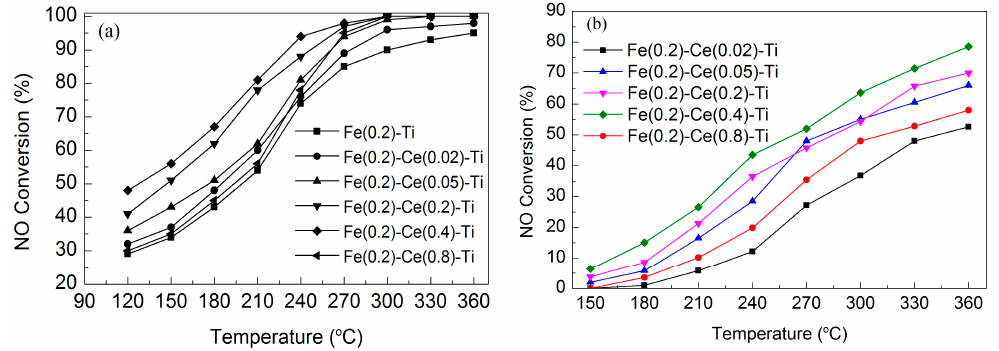
Figure 2. NO conversion of various Fe–Ce–Ti catalysts at different GHSVs: ( a ) GHSV = 90,000 h − 1 and ( b ) GHSV = 180,000 h − 1 . Reaction conditions: [NO] = [NH 3 ] = 500 ppm, [O 2 ] = 5 vol. %, N 2 balance.